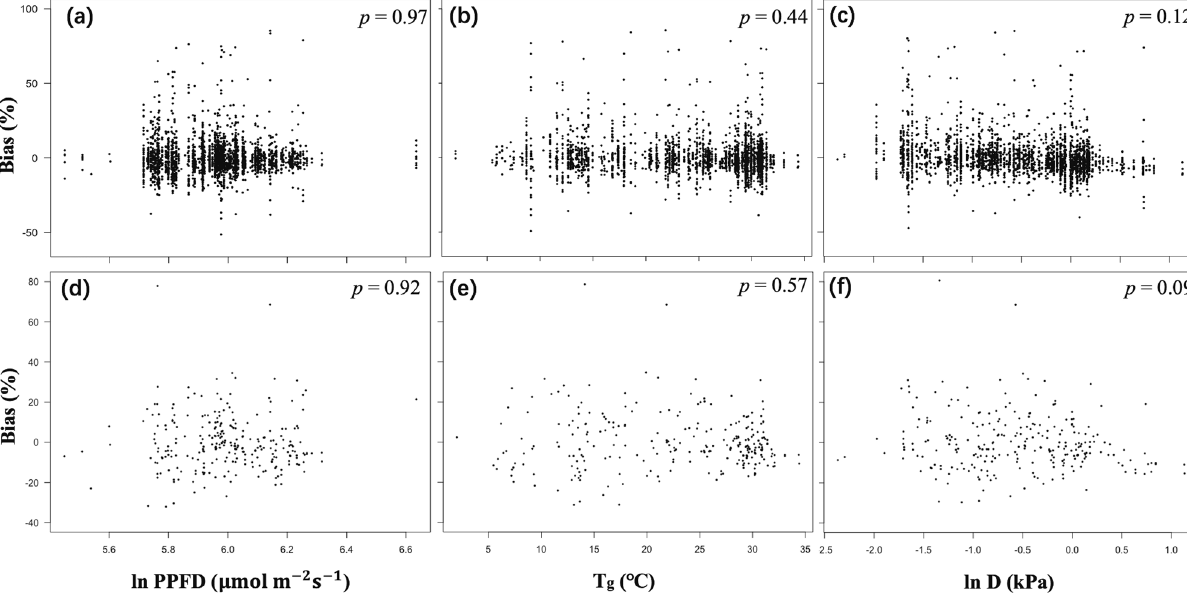
Fig. 2 Partial residual plots for the model bias of theoretically predicted V cmax25 values in relation to climate variables. Partial residual plots for the model bias of theoretically predicted V cmax25 values in relation to climate variables: all-species ( a , b , c ) and site means (d, e, f). Coef fi cients and standard errors for the fi tted lines are given in Supporting Information Table